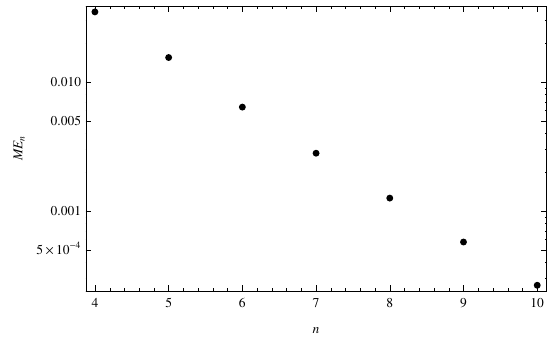
Figure 3: Logarithmic plots of the ME n for n = 4 through